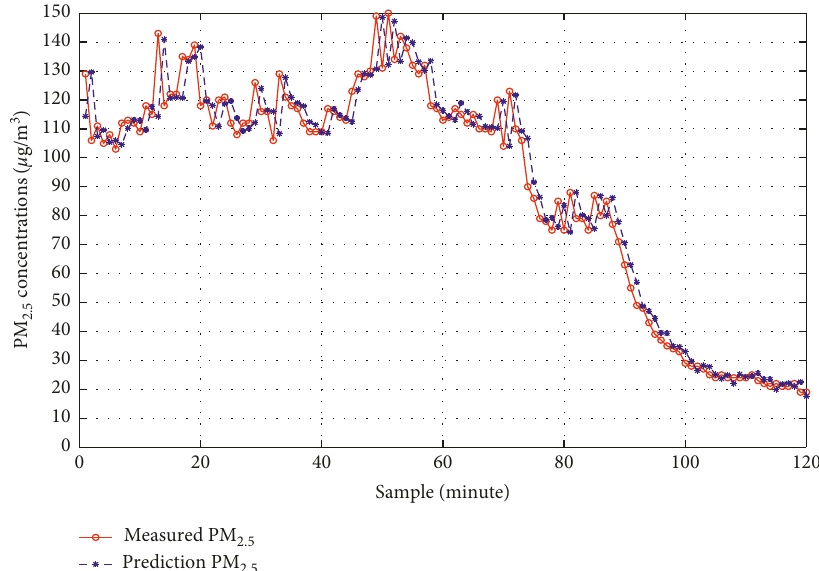
Figure 6: PM 2.5 concentration prediction result of model 2